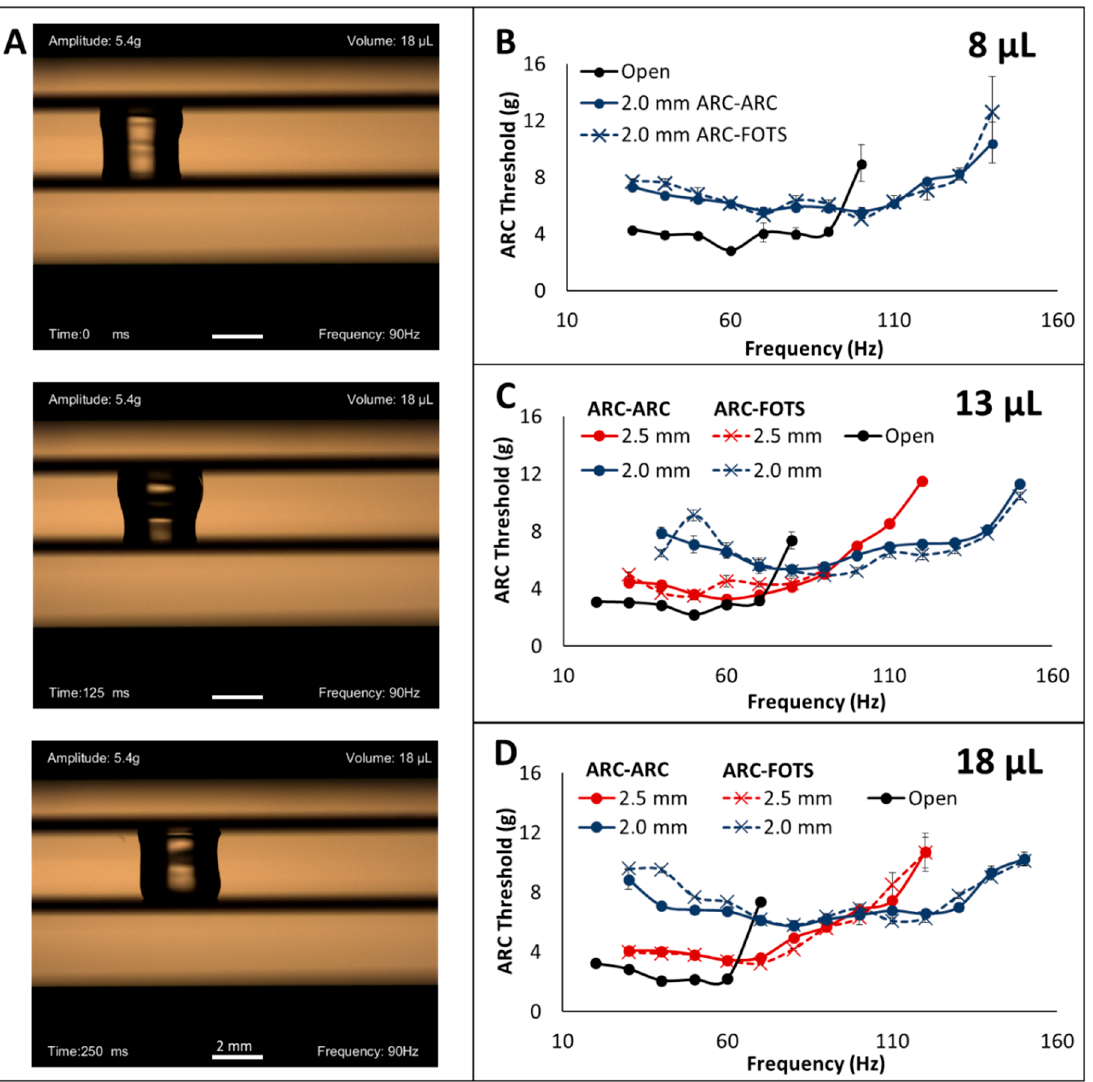
Figure 3. Anisotropic ratchet conveyor (ARC) threshold is dependent on separation distance with a dual-plate system. Droplets transported between two plates ( A ) exhibit a higher ARC threshold at low frequencies, but lower ARC threshold at higher frequencies, as well as a larger functional frequency range ( B – D ). This trend also repeats as the separation distance between plates is reduced. These observations are consistent for both ARC-ARC and ARC-FOTS configurations and all droplet volumes. Data are provided for measurements of ARC thresholds on three ARC devices and error bars represent ± standard deviation. Scale bars show 2 mm on droplet images.